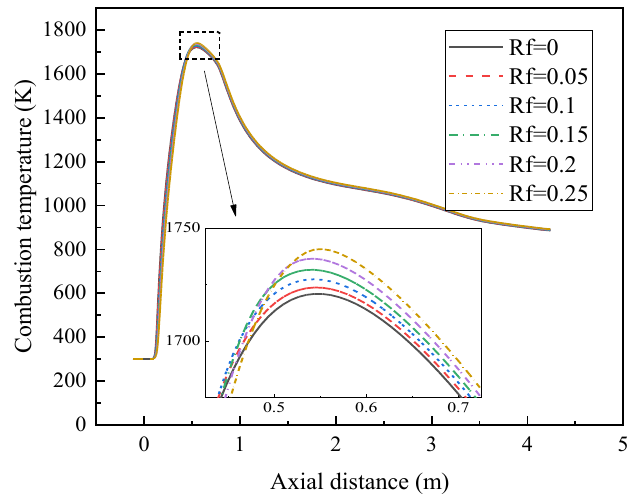
Figure 10. Axial temperature distribution.